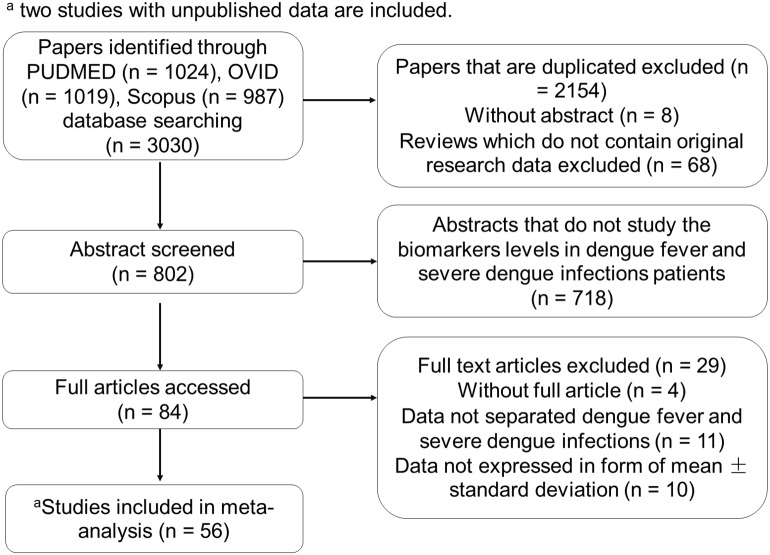
Flow chart of the study’s selection process.